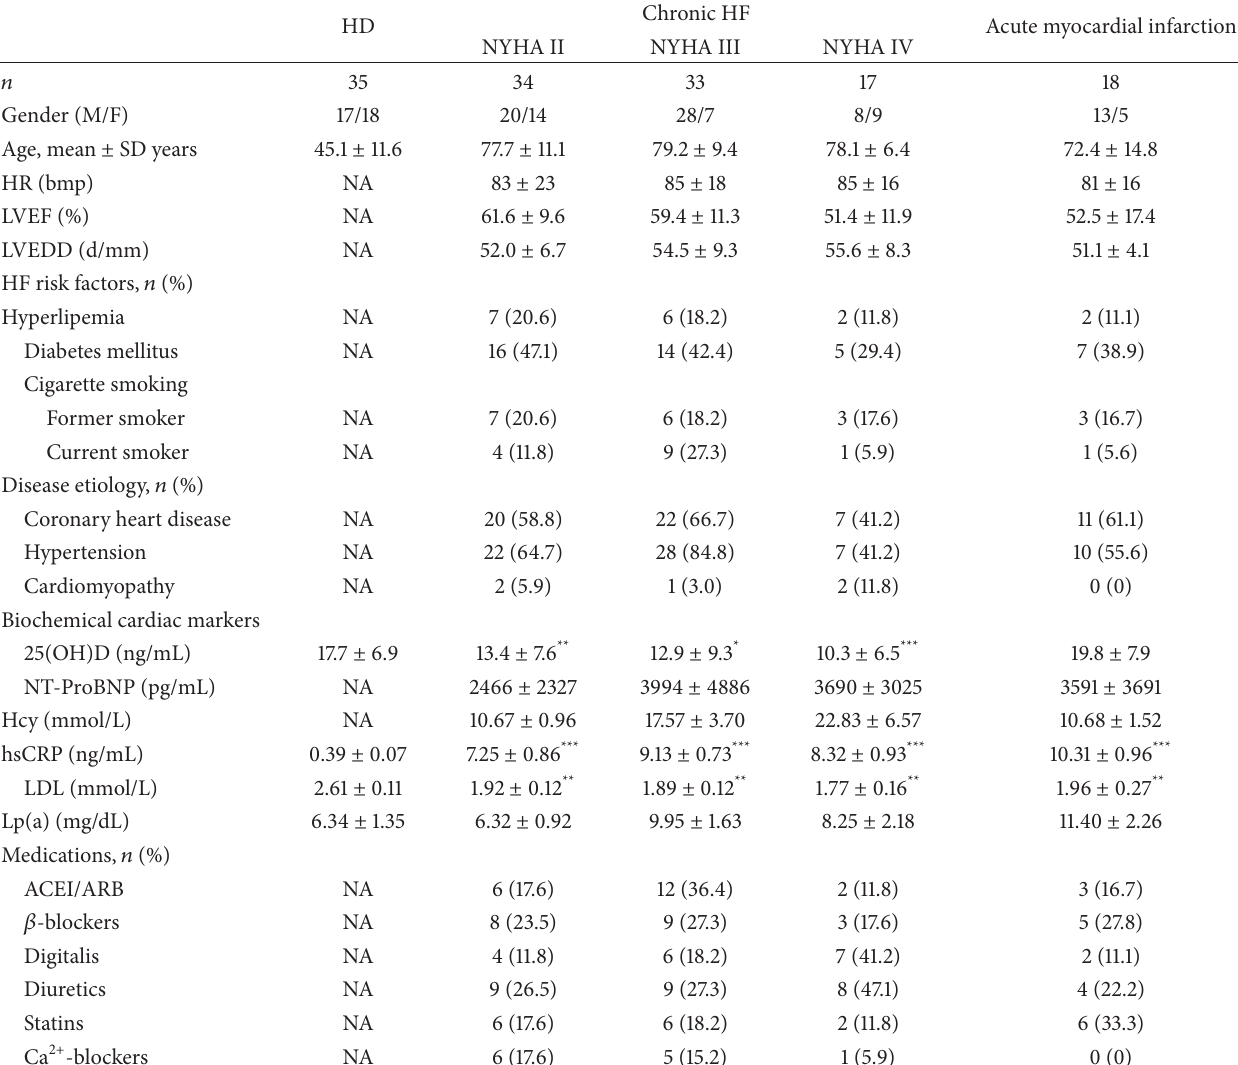
Table 1: Characteristics of chronic heart failure patients and healthy